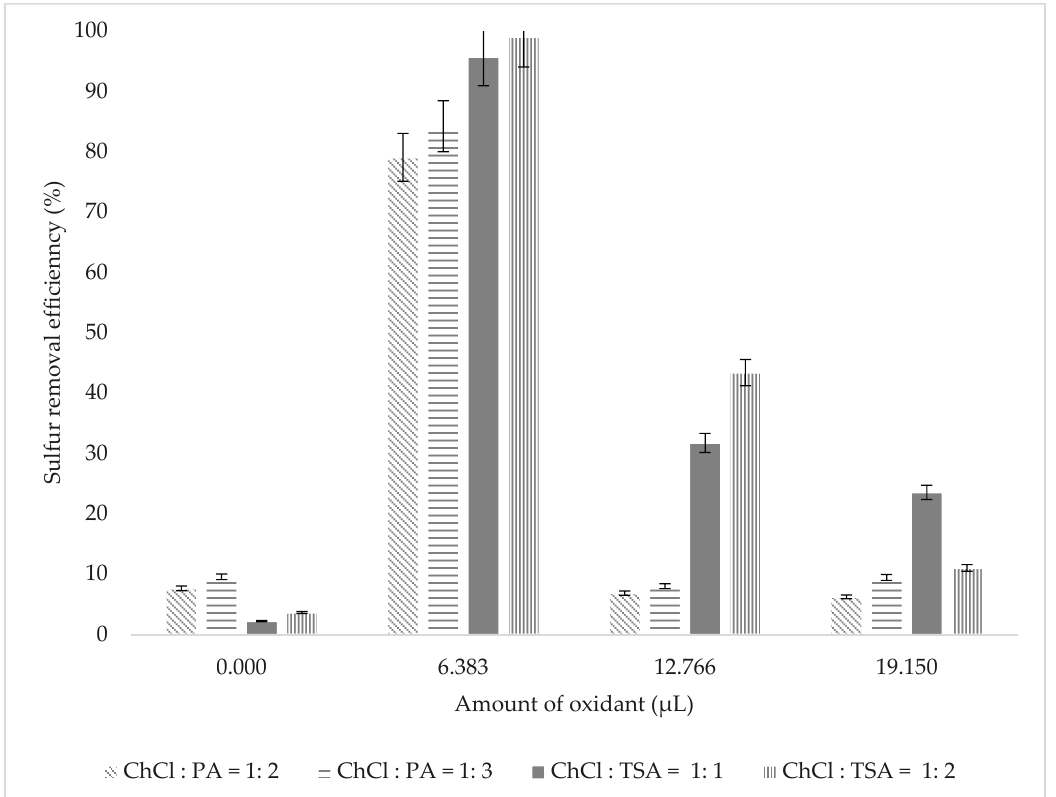
Figure 3. The effect of ratio of the oxidant to DBT in the model oil on the sulfur removal efficiency (0.01 g Cu-Fe/TiO 2 , 10 mL of 100 ppm model oil (DBT), room temperature, EIL to model oil ratio of 1:5, and 300 rpm stirring speed).